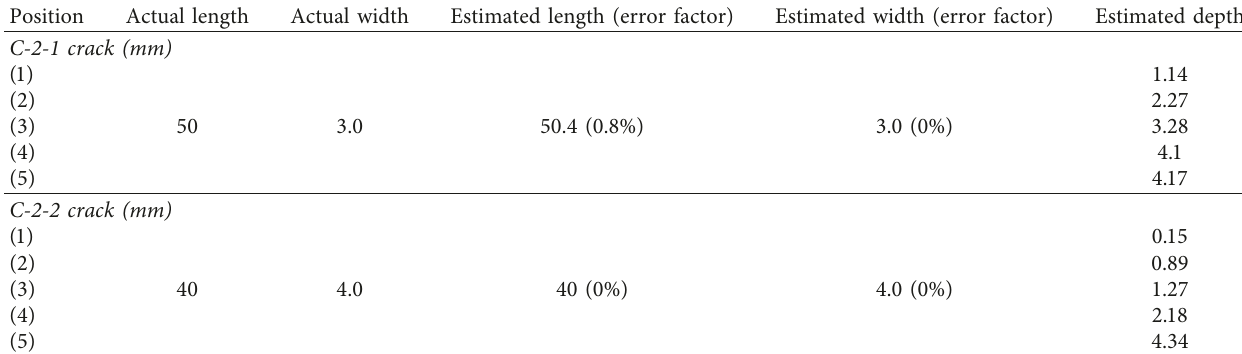
Figure 26: Inspection results for the C-2-2 natural crack: (a) C-scan and cross section amplitude of (b) radial direction and (c) cir- cumferential Table 6: Inspection results for C-2-1 and C-2-2 crack (mm).